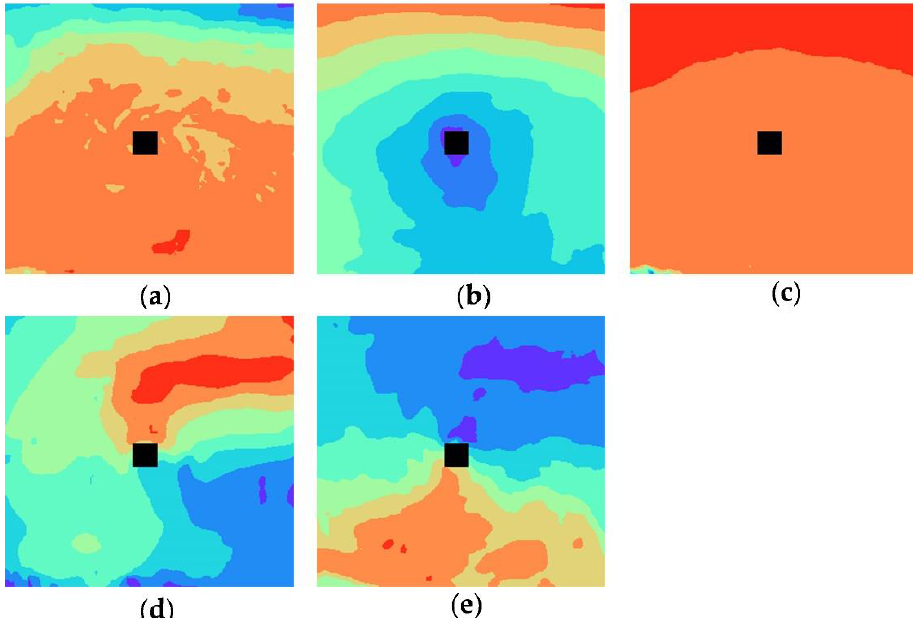
Figure 3. Heat maps of physical variables marking the position of the typhoon ’s center: ( a ) 2 m dewpoint temperature; ( b ) mean sea level pressure; ( c ) surface pressure; ( d ) significant height of combined wind waves and swell; ( e ) 10 m u-component of wind.